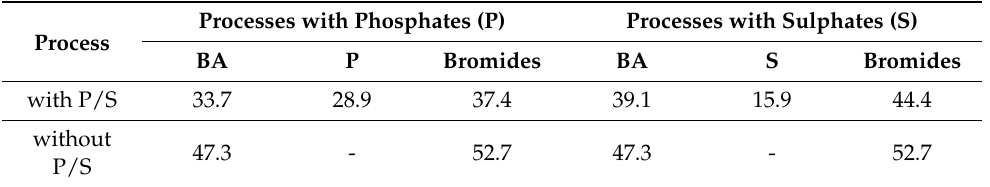
Table 1. Fraction of hydroxyl radicals (%) reacted with benzoic acid (BA = 24 µ M), bromides (15 µ M) and phosphates ( p = 50 mM) or sulphates (S = 50